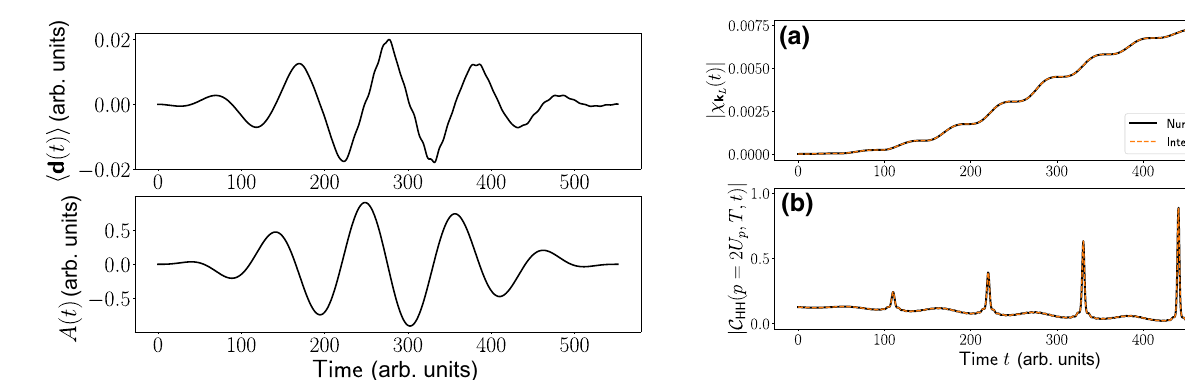
( t ) and (b) C ( p = 2 U ) FIG. 19. Behaviors of (a) χ k HH p , T , t L with a time interval of (cid:13) t = 1.0 (solid black curve), and the func- tion obtained from the interpolation (dashed orange curve). For the interpolation plot, we considered a time step (cid:13) t =